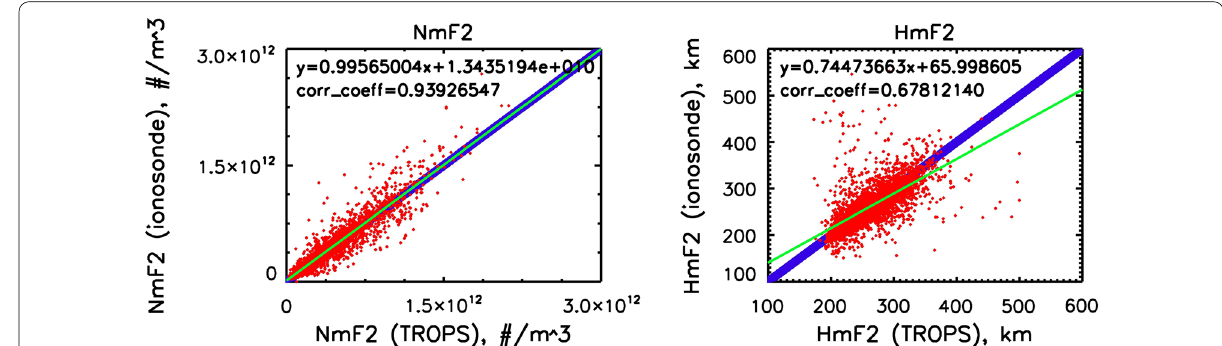
Fig. 5 Comparison between F7/C2 electron density profiles and ionosonde observations from day of year 001 to 100 in 2020. The ionosonde data are from DIDbase. The time and spatial differences between the F7/C2 observations and the ionosonde data are in increments of 5 min and 3°, respectively, for comparison. The blue and green lines indicate when the slope of the line is equal to 1 and the linear regression line, respectively: (left) comparison of NmF2 between F7/C2 electron density profiles and ionosonde observations; (right) comparison of HmF2 between F7/C2 electron density profiles and ionosonde observations